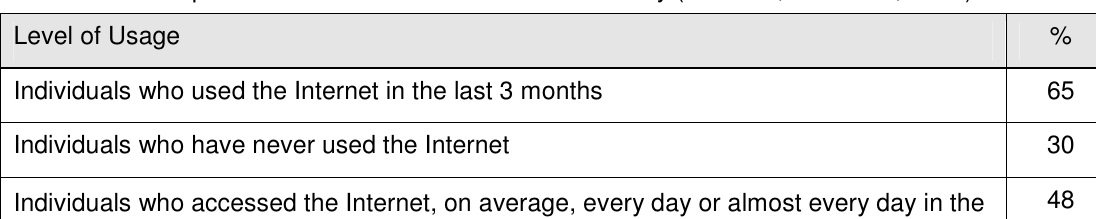
Table 1: Europe-27 indicators for the Information Society (Eurostat, March 31, 2010) Level of